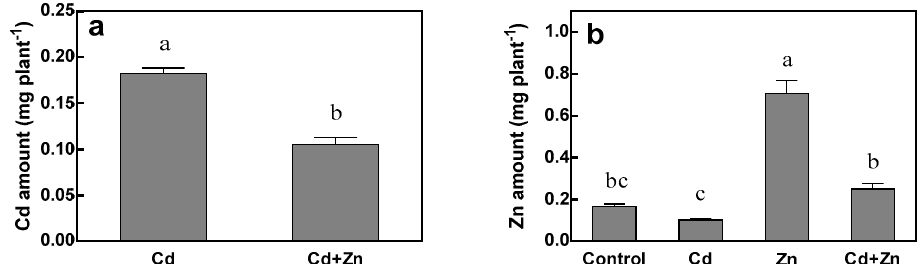
Figure 4. Cd amount ( a ) and Zn amount ( b ) of tall fescue. Plants were grown for 15 days in solutions under control (0 µ M Cd + 15 µ M Zn), Cd (75 µ M Cd + 15 µ M Zn), Zn (0 µ M Cd + 115 µ M Zn) and Cd + Zn (75 µ M Cd + 115 µ M Zn) treatments. Error bars represent ± SEM of three replicates. Means with a common letter did not di ff er significantly (Duncan’s test, p < 0.05). The two-way